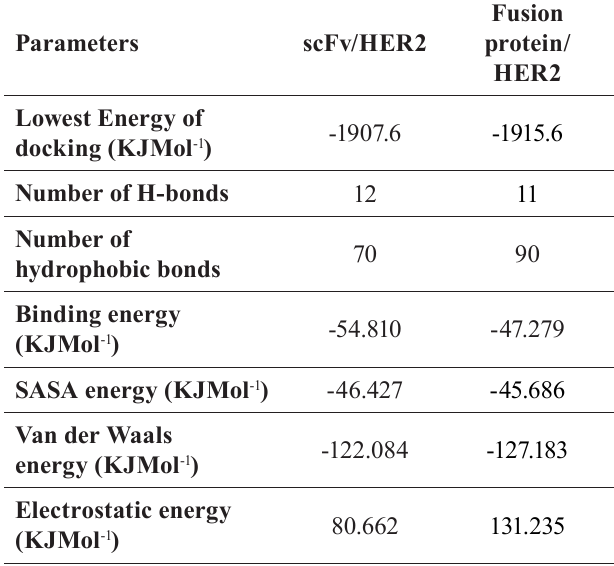
TABLE III - Docking and G_MMPBSA calculations